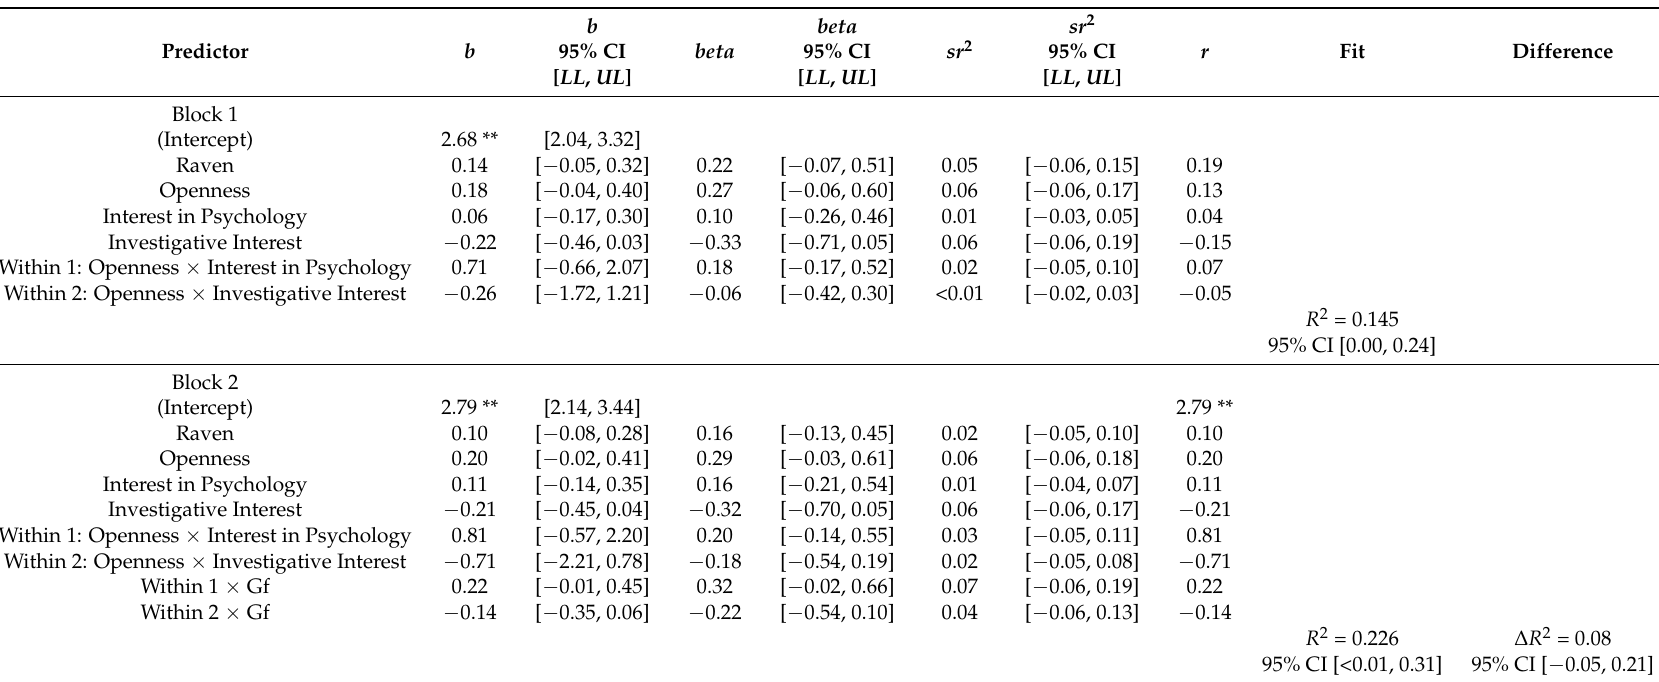
Table 4. Regression results using grades as the